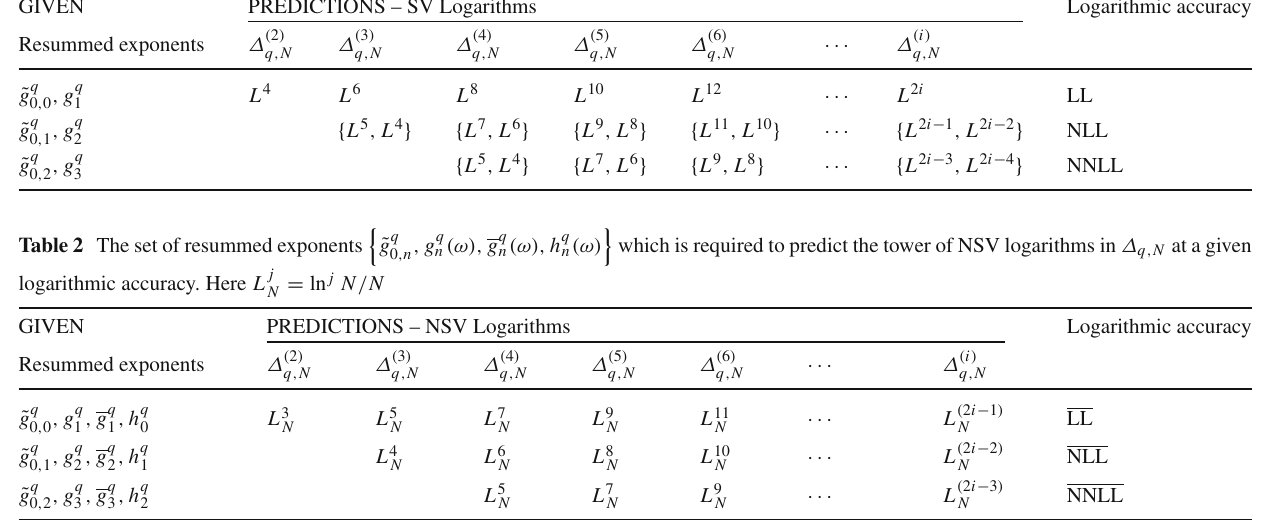
Table 1 The set of resummed exponents accuracy. Here L j = ln j N